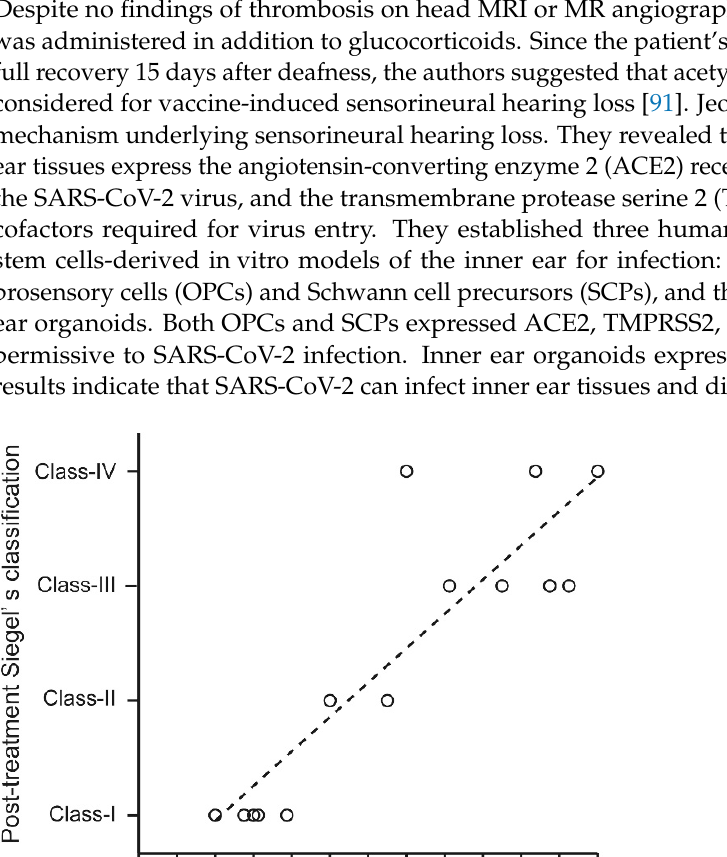
Table 3. Characteristics of coronavirus disease-related sudden sensorineural hearing loss.